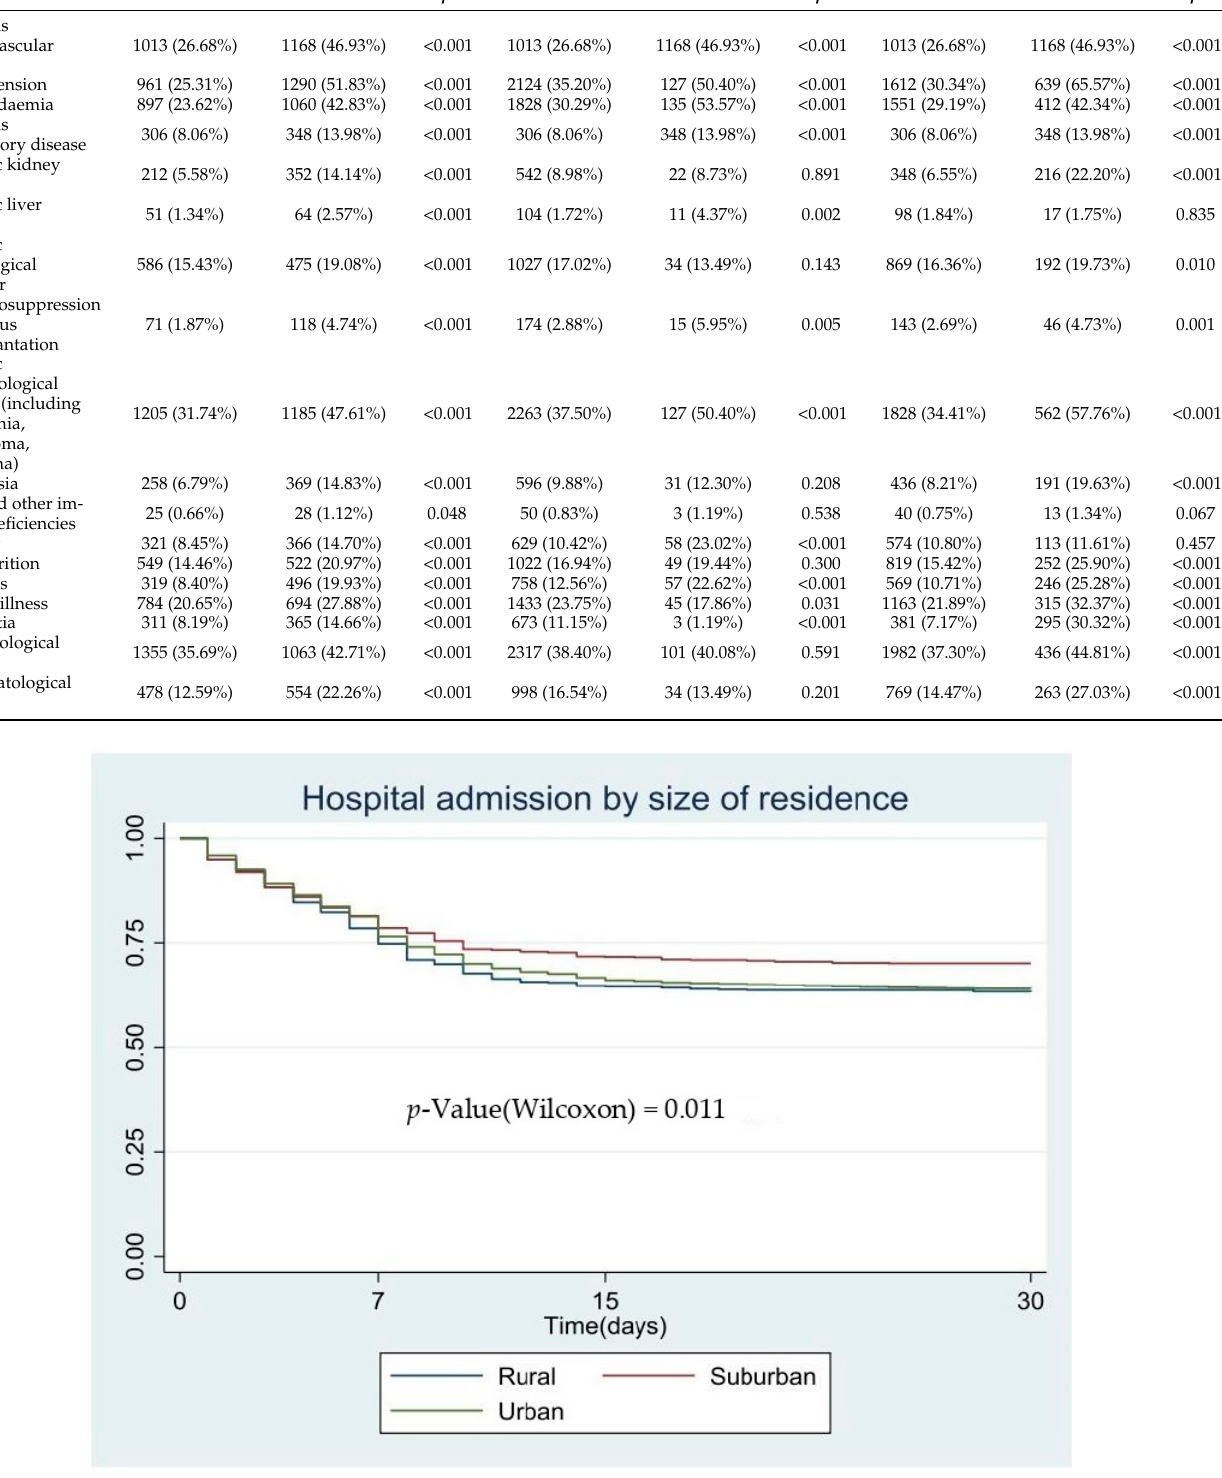
Figure 1. Hospital admission by size of residence, Kaplan–Meier survival.